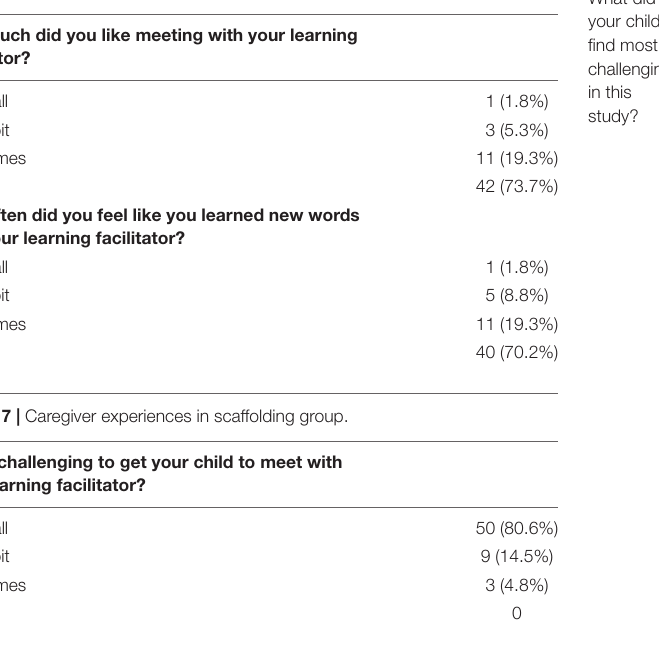
TABLE 6 | Child experiences in scaffolding group.